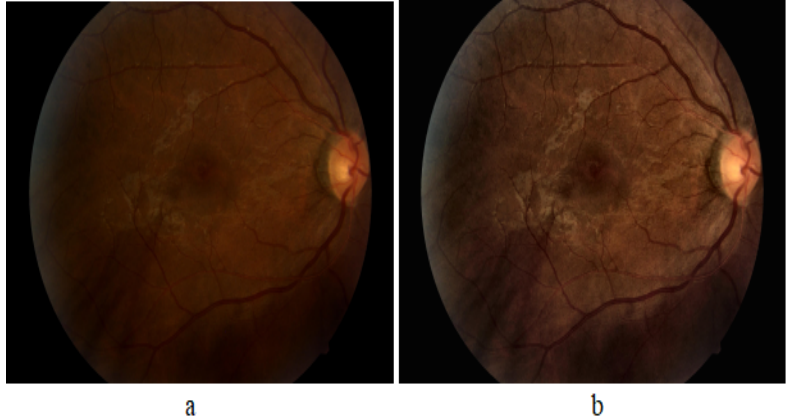
Figure 3. Effect of applying CLAHE; ( a ) original; and ( b ) CLAHE processed.